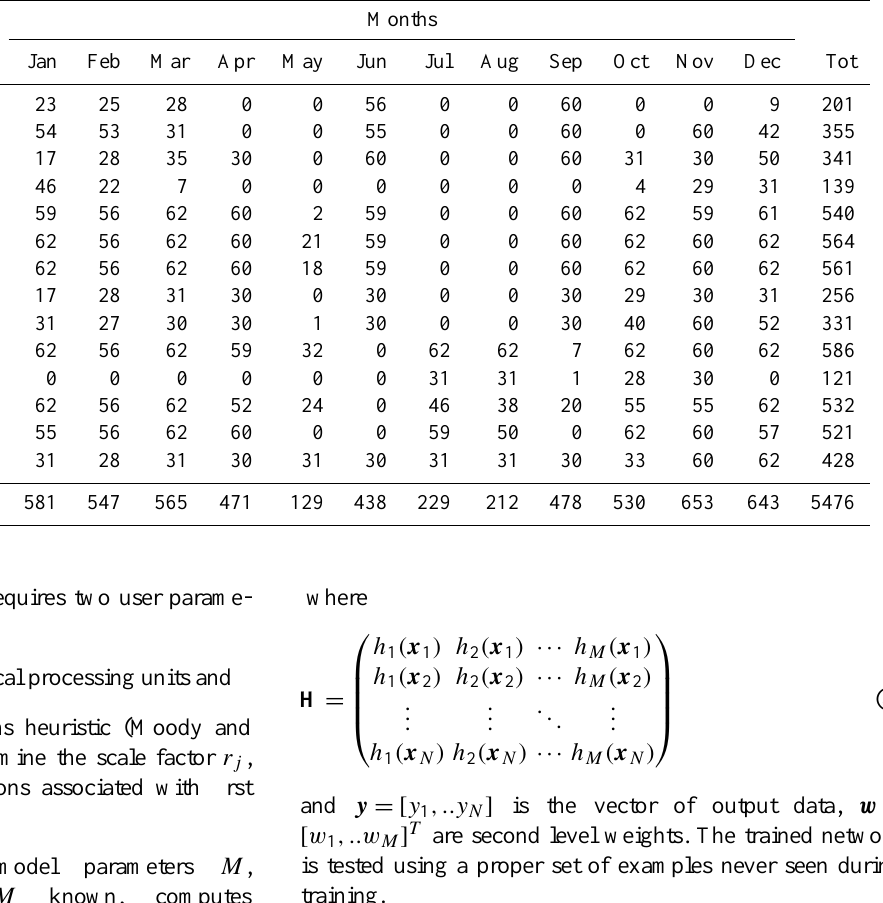
Table 2. Amount of data in the final dataset. The division into months and altitude has been applied to emphasize the diversity and incom- pleteness of the data